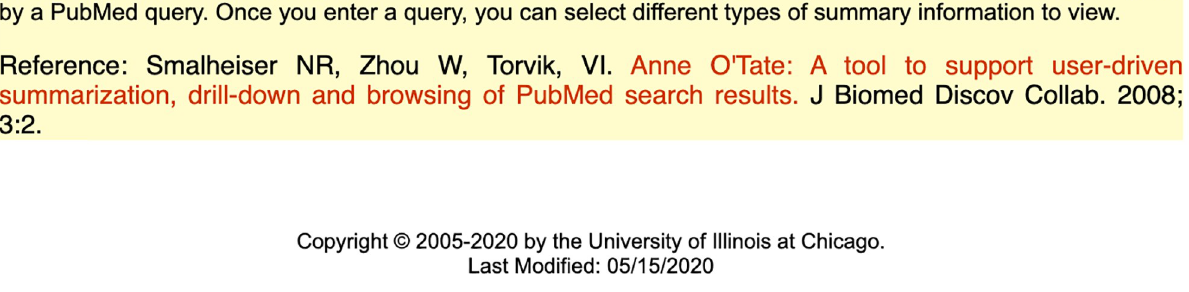
Fig 1. Screenshot of the Anne O’Tate homepage. Each displayed article (Fig 2) has two hotlinks on its right side: “Related articles” opens a new tab that displays a ranked list of the most related articles as computed by PubMed using the PubMed related article algorithm which is largely based on word usage similarity [9]. The “Citations” hotlink opens a new tab that displays the Citation Cloud surrounding that article (see